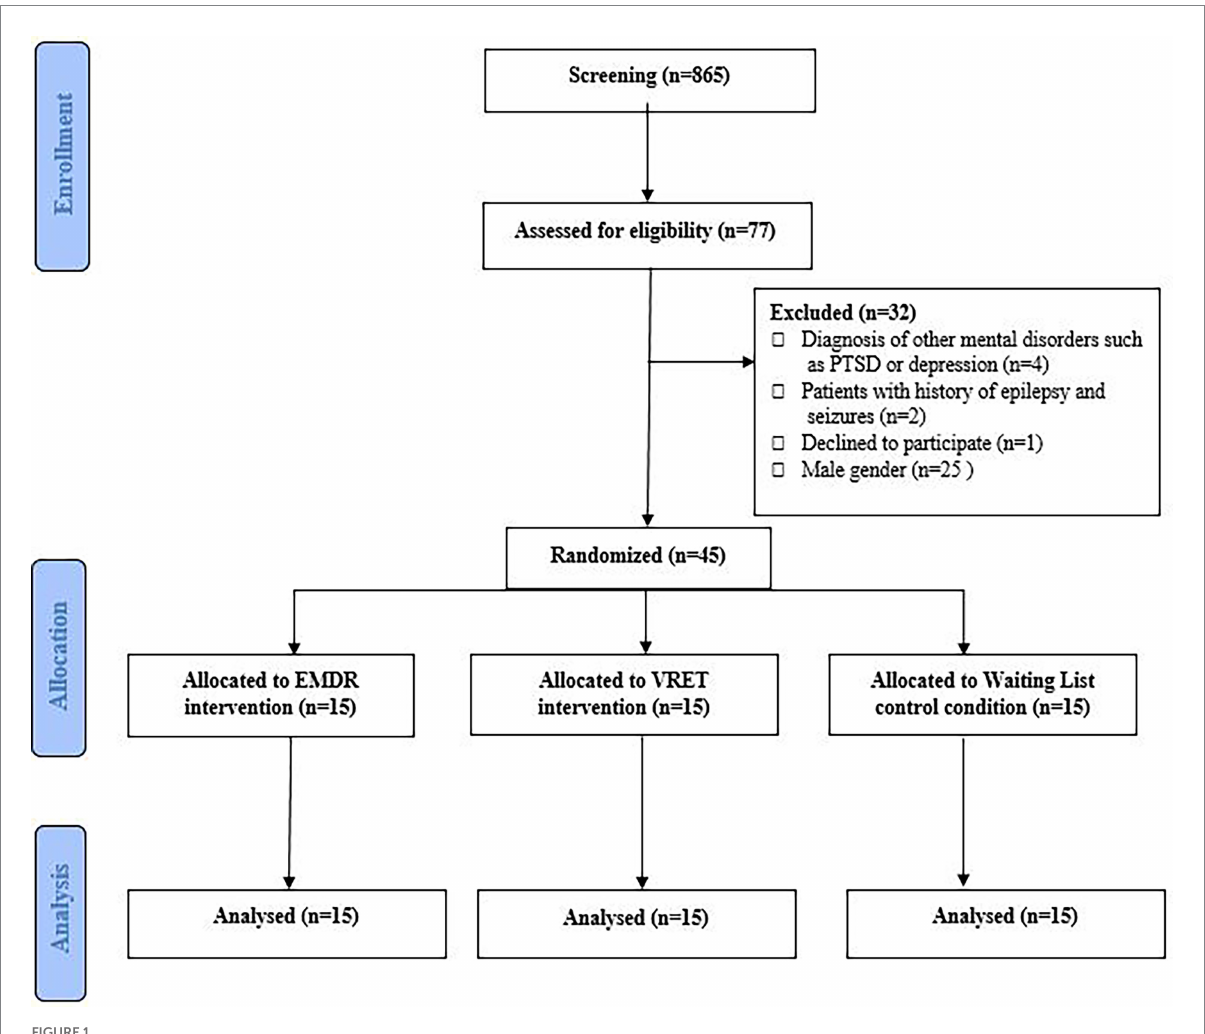
FIGURE 1 CONSORT flowchart for study